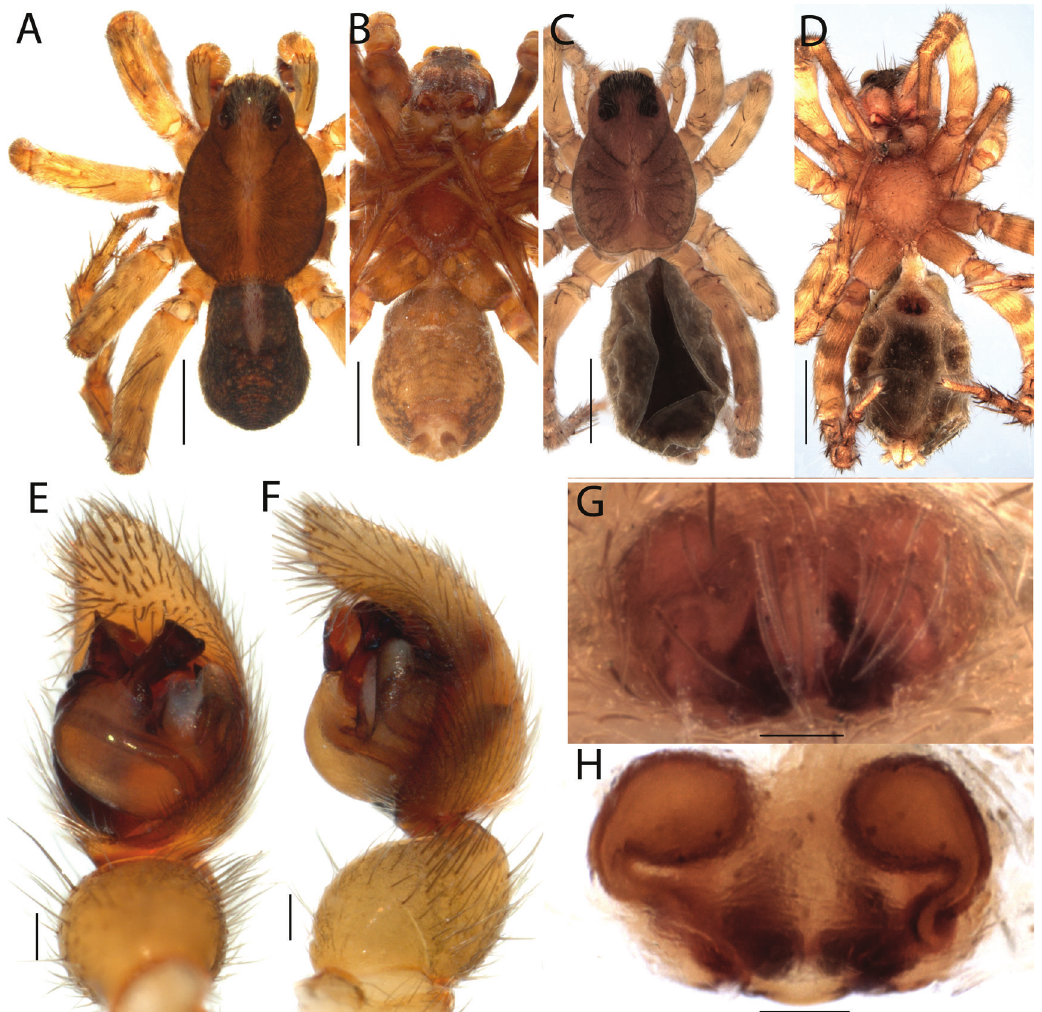
Figure 9. Artoria belfordensis sp. n., male holotype (AM KS127759), female paratype (AM KS73425): A , male habitus, dorsal view; B , male habitus, ventral view; C , female habitus, dorsal view; D , female habitus, ventral view; E, male pedipalp, ventral view; F , male pedipalp, retrolateral view; G , epigyne, ventral view; H , epigyne, dorsal view. Scale bars: habitus 1.0 mm; pedipalp, epigyne 0.1